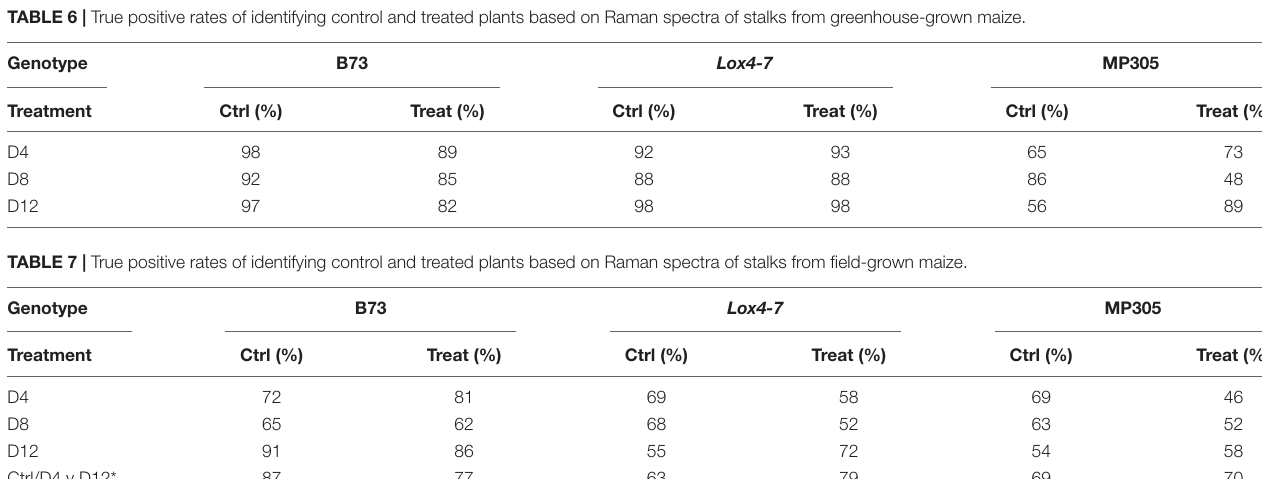
content of scaffold molecules (cellulose and lignin), as well as